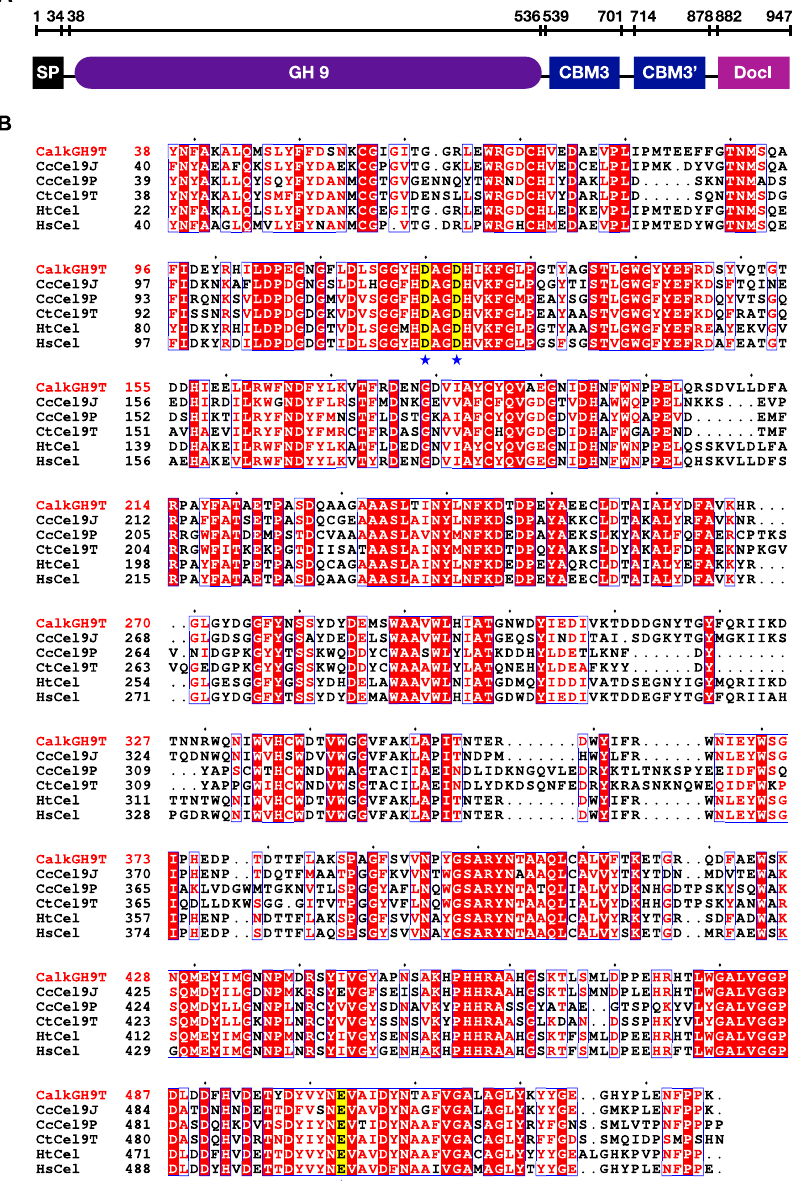
Figure 1. ( A ) Modular architecture of Calk GH9T, showing a full-length sequence (947 amino acids) starting from an N-terminal signal peptide followed by one GH9 catalytic module, two family 3 CBMs, and one dockerin. ( B ) Multiple sequence alignment of catalytic module of Calk GH9T and four selected GH9 enzymes. Identical residues are shown in white with a red background, whereas amino acid replacements (conservative changes) are shown in red with a white background. The three conserved catalytic residues are highlighted in yellow and marked with stars. The sequences were aligned by use of Clustal Omega [ 22 ] and the sequence alignment was displayed by using ESPript [ 23 ] .